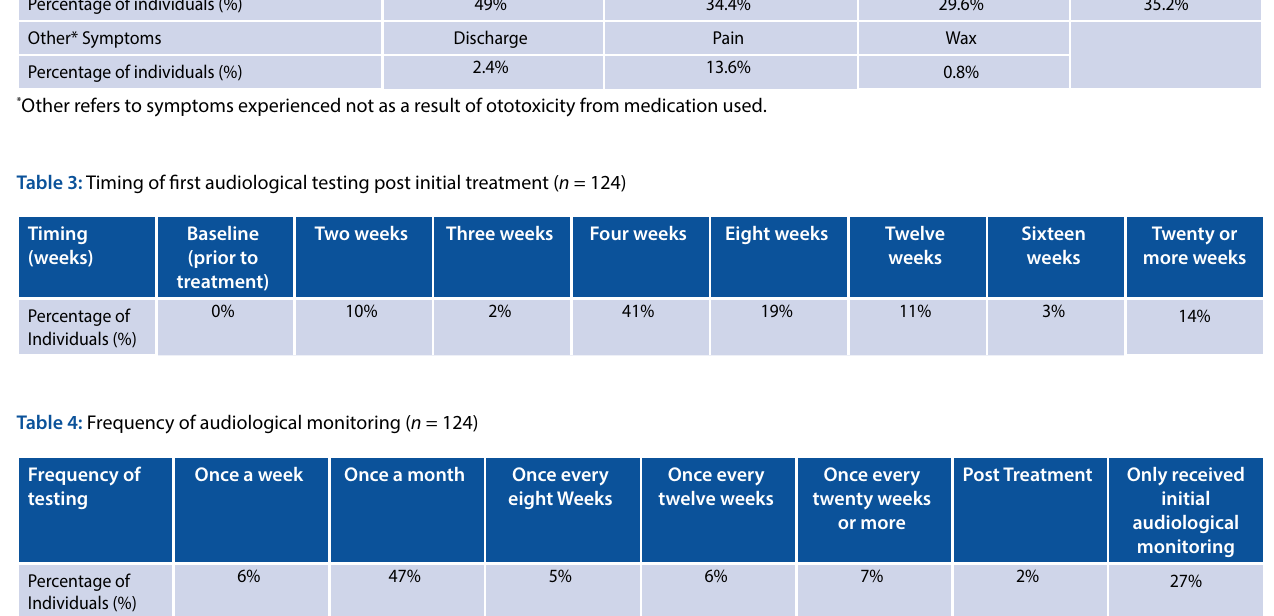
Table 2: Patient complaints of symptoms related to ototoxic medication and other* symptoms ( n = 124).